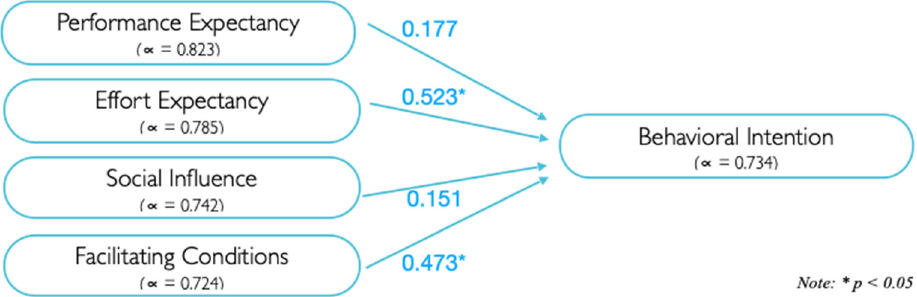
Figure 5. Correlation between the different dimensions of the UTAUT at D0—SHERPAM project. At D0, two variables are related to Behavioral Intention: Effort Expectancy and Facilitating Conditions. There was no effect of moderators on the results at D0. Table 4. Correlation Matrix UTAUT dimensions—SHERPAM project D0.